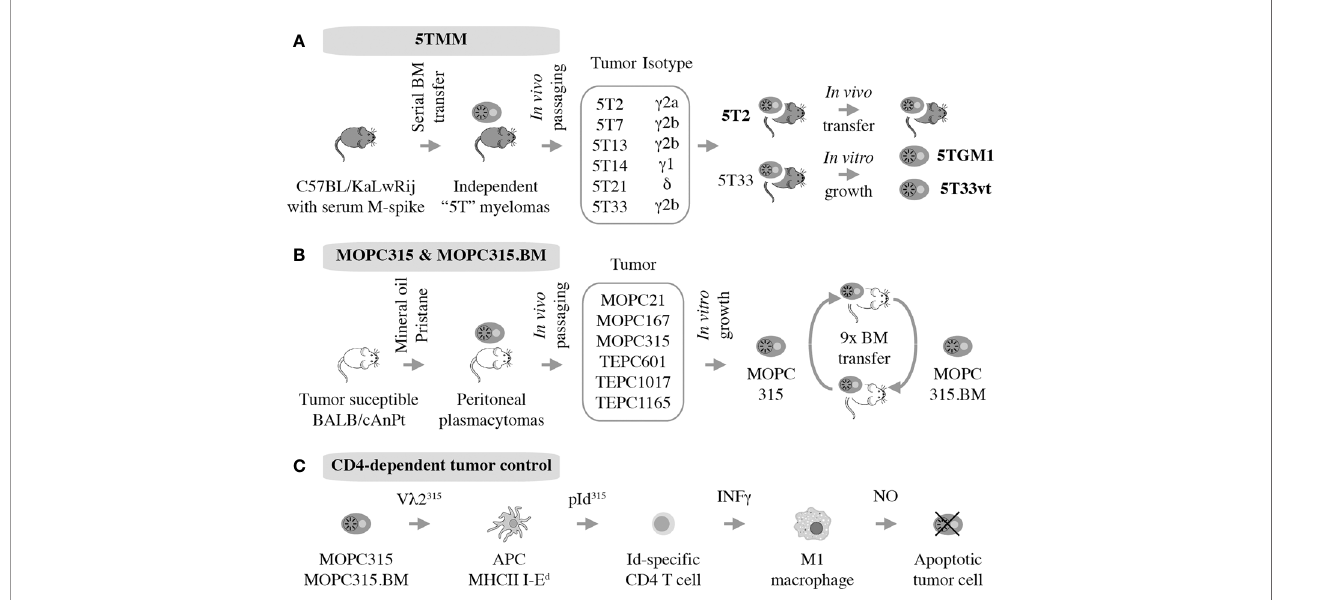
FIGURE 4 | Autografting mouse myeloma in immunocompetent mice. Two models have been established. 5TMM is on a genetic background that is highly similar to B6 and includes two continuous cell lines, 5TGM1 and 5T33vt, that are widely used (A) . MOPC315 is a peritoneal plasmacytoma on the genetic background of C that has given rise to a BM-seeking subline, MOPC315.BM, that holds great value for myeloma immunology research. (B) Decades of research by Bogen and colleagues have shown indirect CD4+ T cells mediated killing via interactions with cytotoxic macrophages, further demonstrating the utility of MOPC315.BM as an immunological research tool (C)